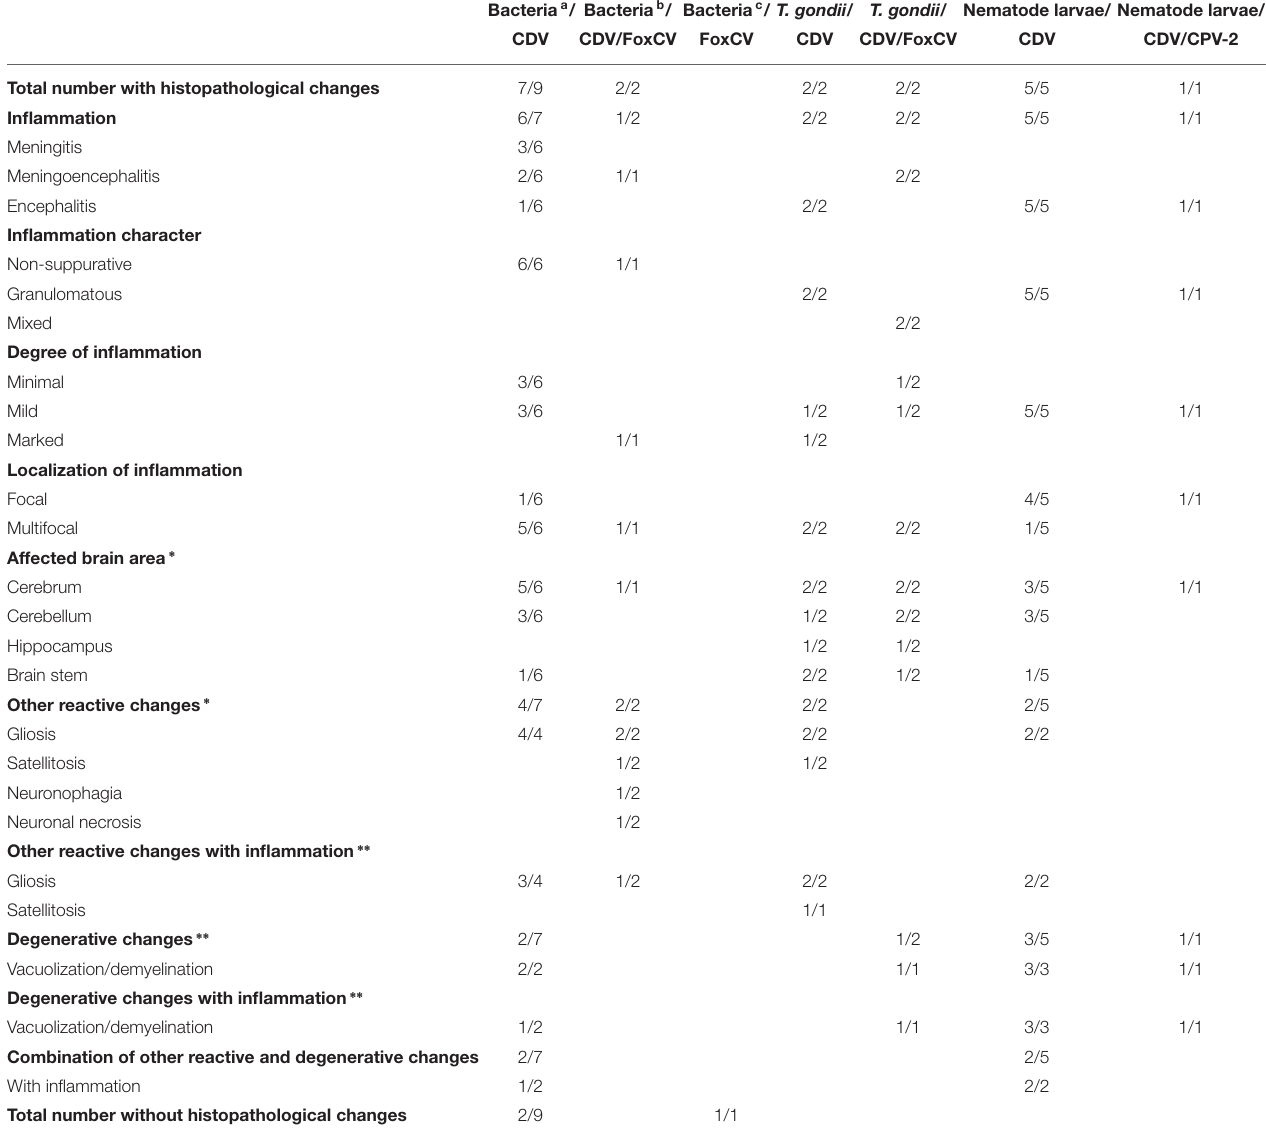
TABLE 3 | Histopathological findings in animals with the combinations of bacteria or parasites and canine distemper virus (CDV), canine parvovirus type 2 (CPV-2), and/or fox circovirus